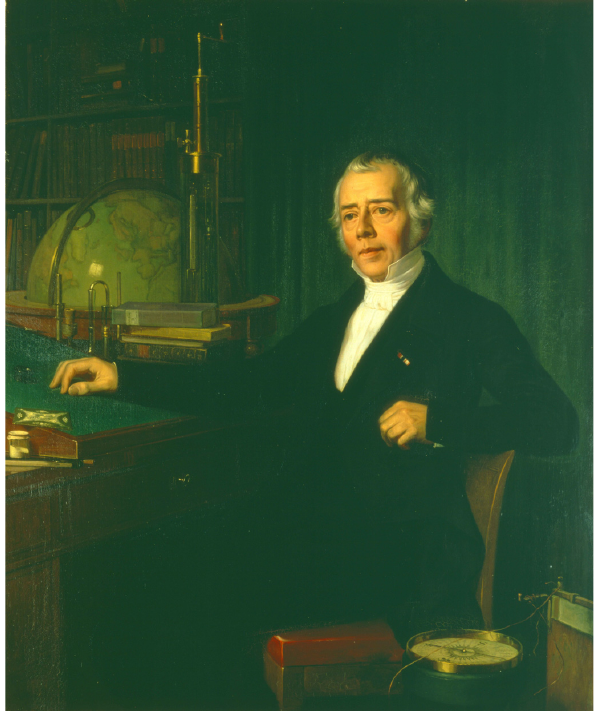
Figure 5. Hans Christian Ørsted (1777–1651) (Frederiksborg Mu-